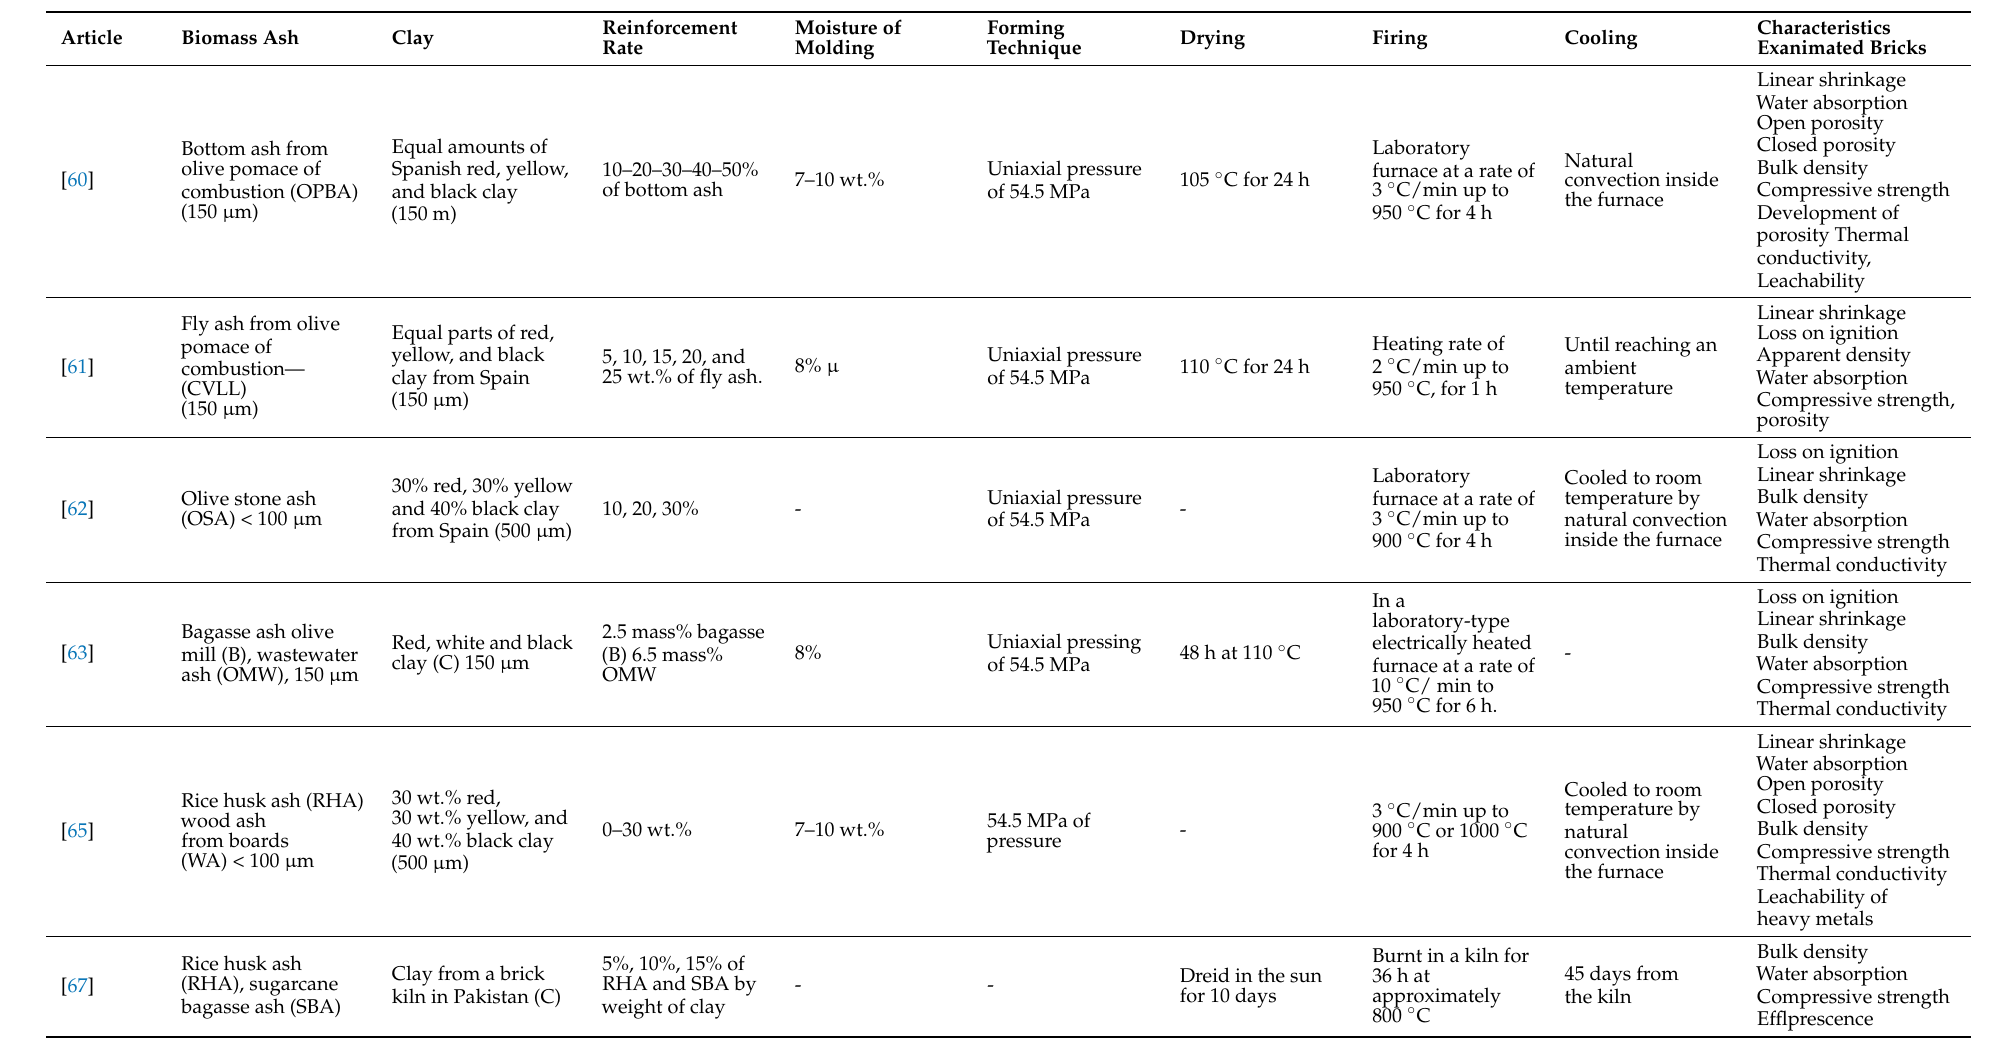
Table 1. Studies on the production of bricks from lignocellulosic biomass ash waste materials through